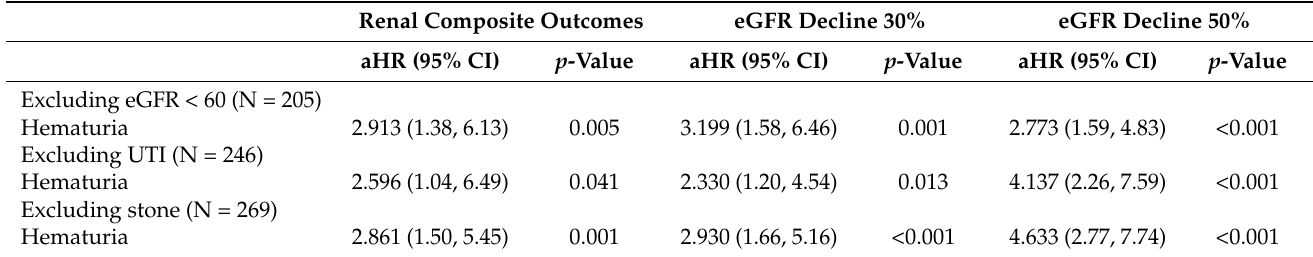
Table 5. Sensitivity